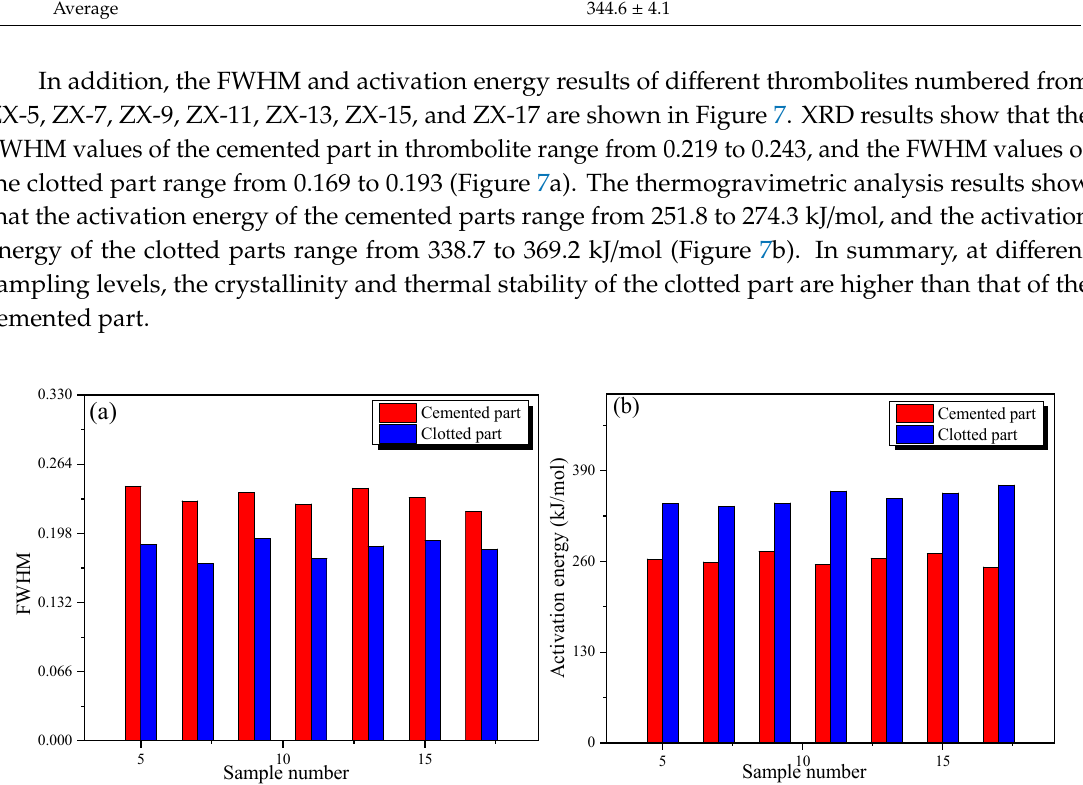
Figure 7. Full Width at Half Maximum (FWHM) ( a ) and activation energy ( b ) of cemented and clotted parts in thrombolite.